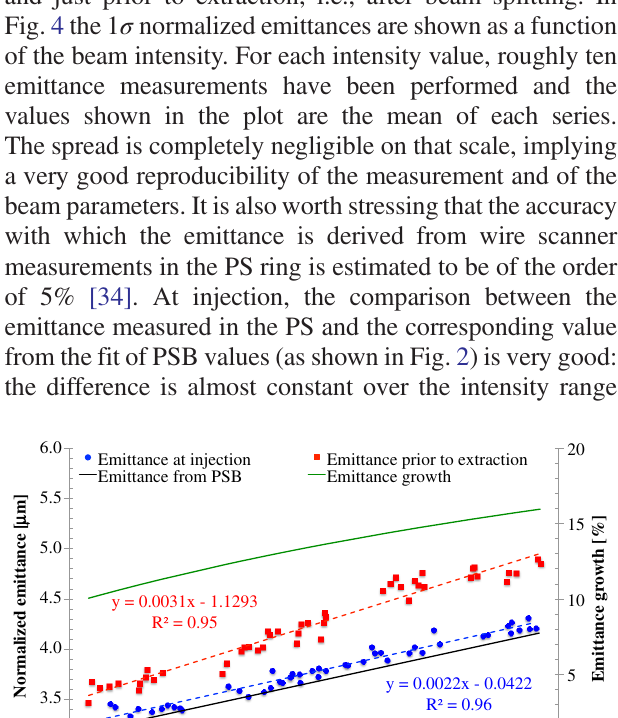
FIG. 3. Upper: Time evolution of the strength of the key families of sextupoles, octupoles, and of rf voltage during the resonance crossing process. Bottom: The variation of the corre- sponding main observables of beam dynamics is also shown. δ b is the bucket height and is equal to 3 σ δ , with σ δ the rms beam momentum spread. The location of the main elements in the PS ring is shown in Fig. 5. The elements with name starting with X or O are sextupoles, or octupoles, respectively.